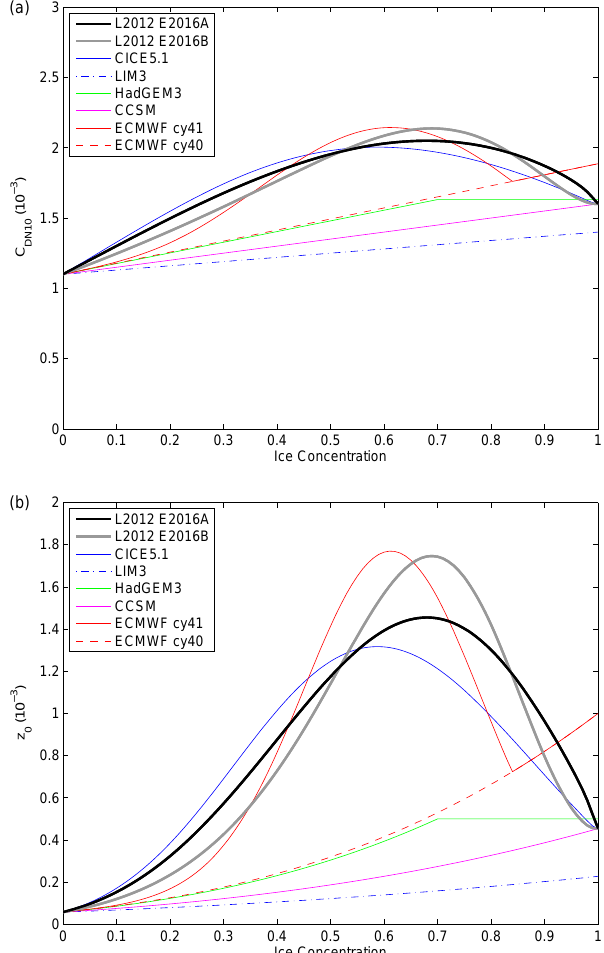
Figure 10. (a) Effective sea-ice drag coefficient and (b) derived effective roughness length as a function of ice concentration. Parametrisations shown are: Lüpkes et al. (2012) with settings as recommended here, namely L2012 E2016A with c e = 0.17 and β = 1 (black), and L2012 E2016B with c e = 0.1 and β = 0.2 (grey); the default L2012 settings used in CICE5.1 (blue) as de- scribed in Tsamados et al. (2014); the LIM3 interpolation (blue dash-dotted); the HadGEM3 default used in the Met Office Unified Model (green); the CCSM (and CAM5) interpolation (magenta); the ECMWF cycle 41 function (red) and the previous ECMWF cycle 40 interpolation (red dashed). See Table 1 for other L2012